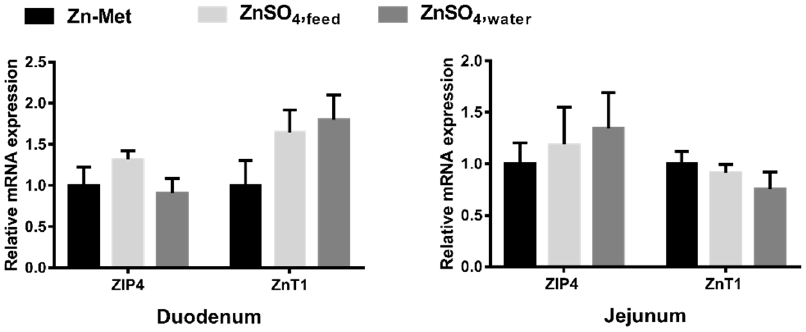
Figure 3. Effect of different Zn supplementation forms on ZIP4 and ZnT1 mRNA expressions in the duodenum and jejunum of piglets.